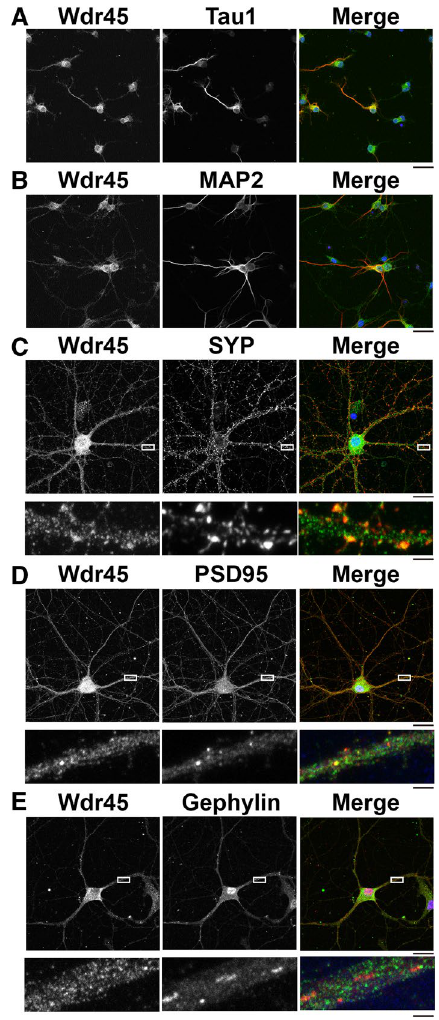
Figure 3. Localization of Wdr45 in primary cultured mouse hippocampal neurons. ( A,B ) Neurons cultured for 3 ( A ) or 7 days ( B ) in vitro were double-stained for Wdr45 with Tau-1 ( A ) or MAP2 ( B ). Merged images were also shown. Scale bars, 20 µm. ( C – E ) Neurons cultured for 14 days were double-stained for Wdr45 with synaptophysin ( C ), PSD95 ( D ) or gephyrin ( E ). Boxed areas in the upper panels were magnified in the lower panels. Scale bars, 20 µm ( upper panels) and 5 µm ( lower